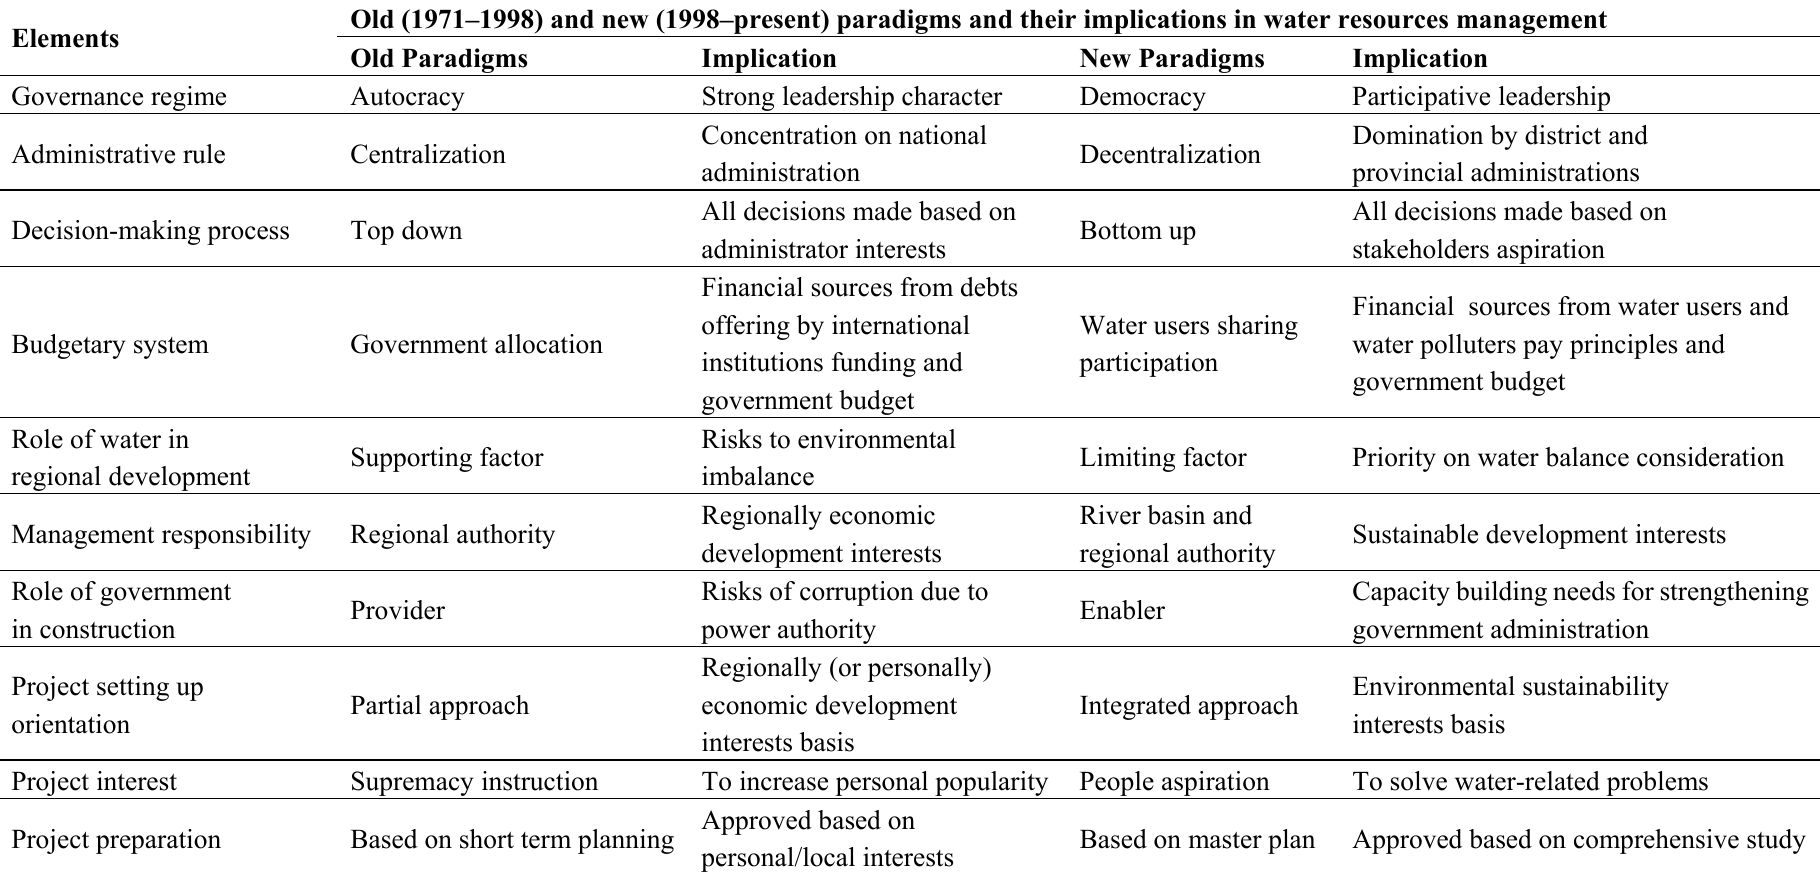
Table 1. Changing paradigms in water resources management in